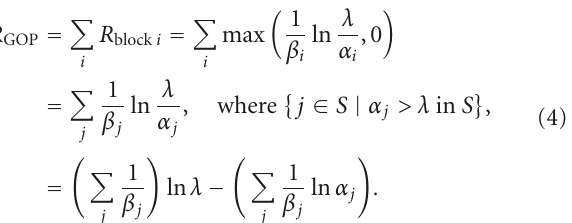
Figure 4: Example of GOP-level R - λ model and real R-D data